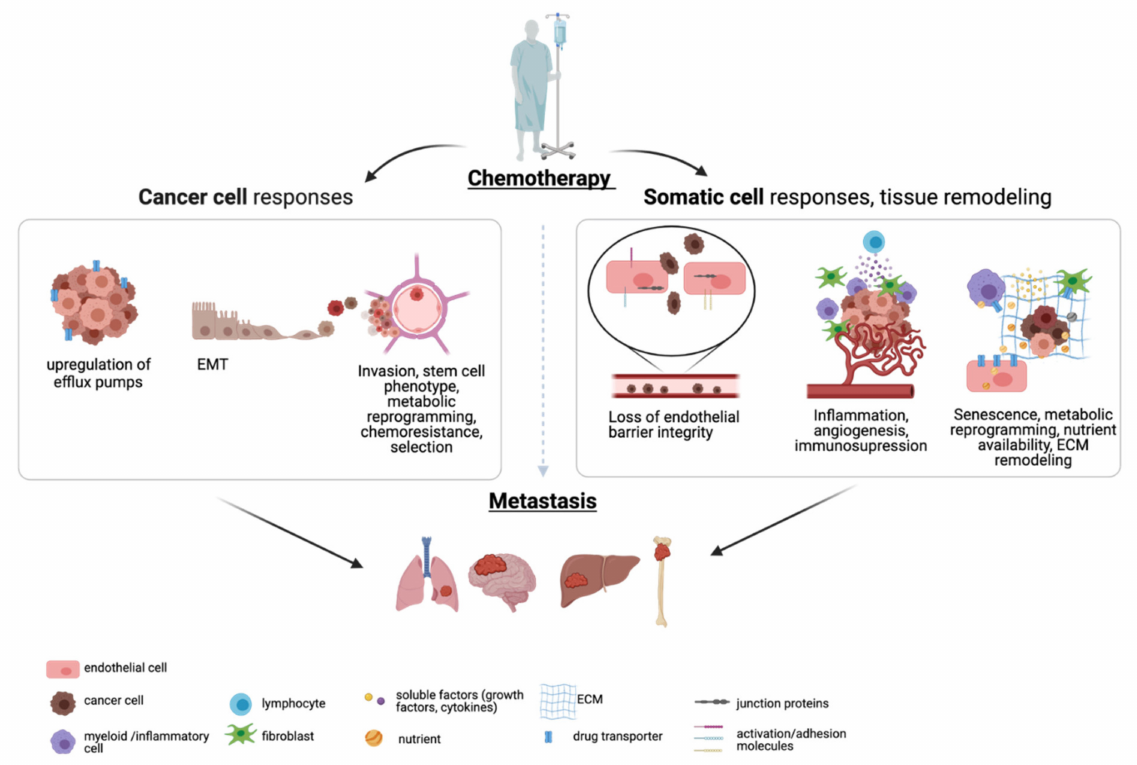
Figure 1. Pathways to Relapse. Chemotherapy-induced relapse includes intrinsic cancer cell resistance, reprogramming and selection, and pro-metastatic changes downstream of somatic cell responses. Cancer cell resistance include overexpression of drug efflux pumps, to actively transport cytotoxic chemicals out of the cancer cell, increased EMT, invasion and adhesion properties, and secretion of extracellular vesicles that prime distant organs (left). Somatic cells in the tumour microenvironment or at distant, tumour-free organs undergo changes in response to chemotherapy. Vascular dysfunction has been shown to contribute to the risk of metastasis and relapse, due to the loss of barrier integrity and resulting vessel leakiness, increasing endothelial activation and a more inflammatory, pro-tumour microenvironment. Chemotherapy also rewires secretory profiles and metabolic preferences, changes in nutrient and substrate availability, which can play into cancer-specific adaptations, often potentiating proliferation and colonisation at secondary sites. Created with BioRender.com (accessed on 5 June 2021)